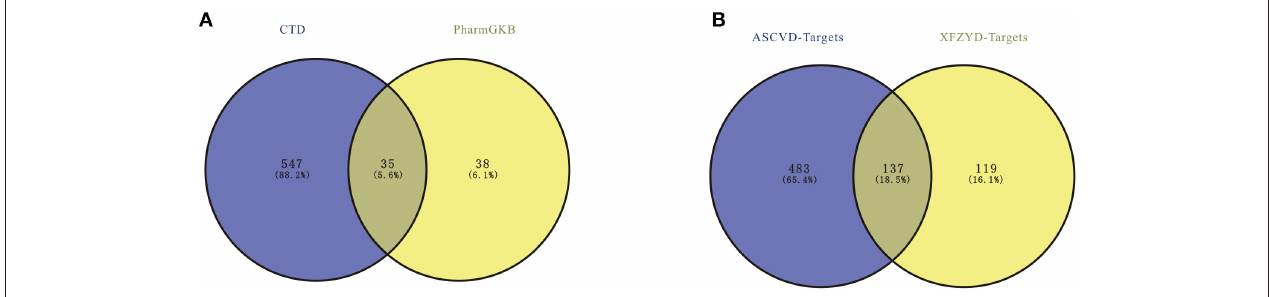
Frontiers in Cardiovascular Medicine |